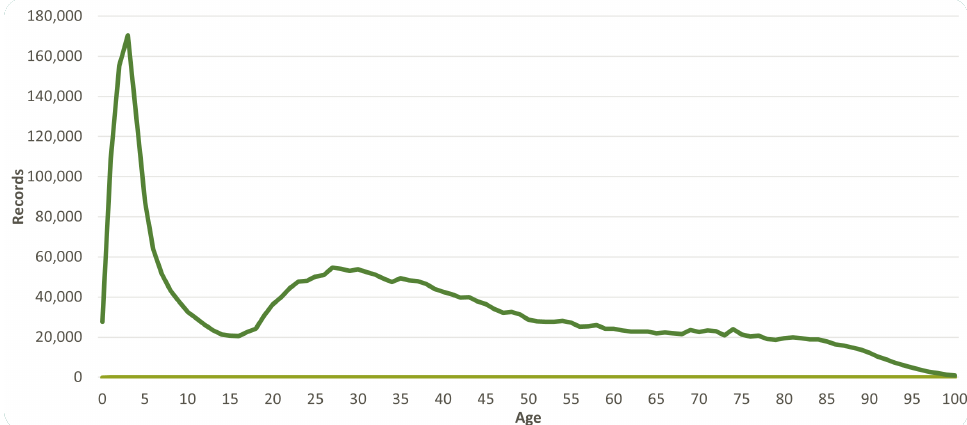
Figure 4. Distribution of calls per the age of the citizen.